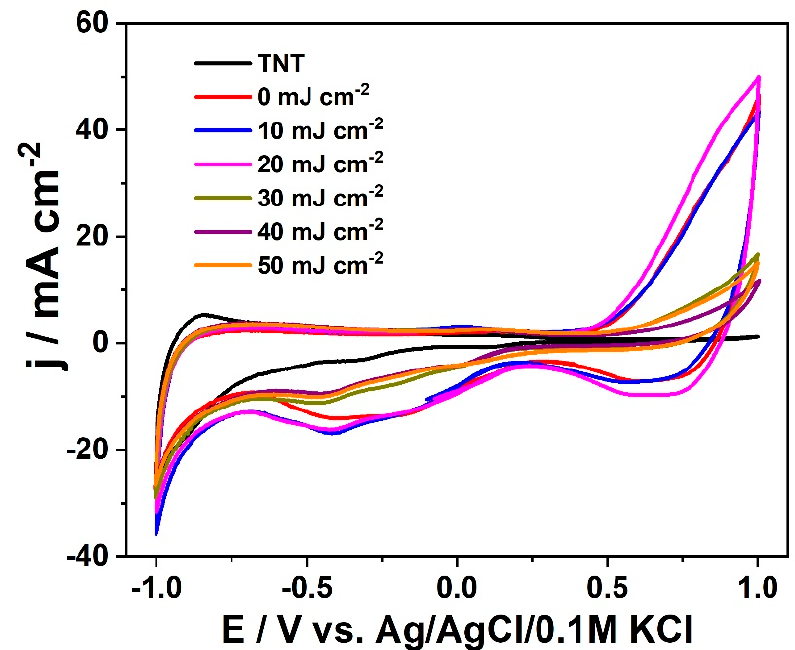
Figure 6. Cyclic voltammetry curves recorded for bare and modified titania recorded with 50 mV s − 1 in 0.5 M Na 2 SO 4 .